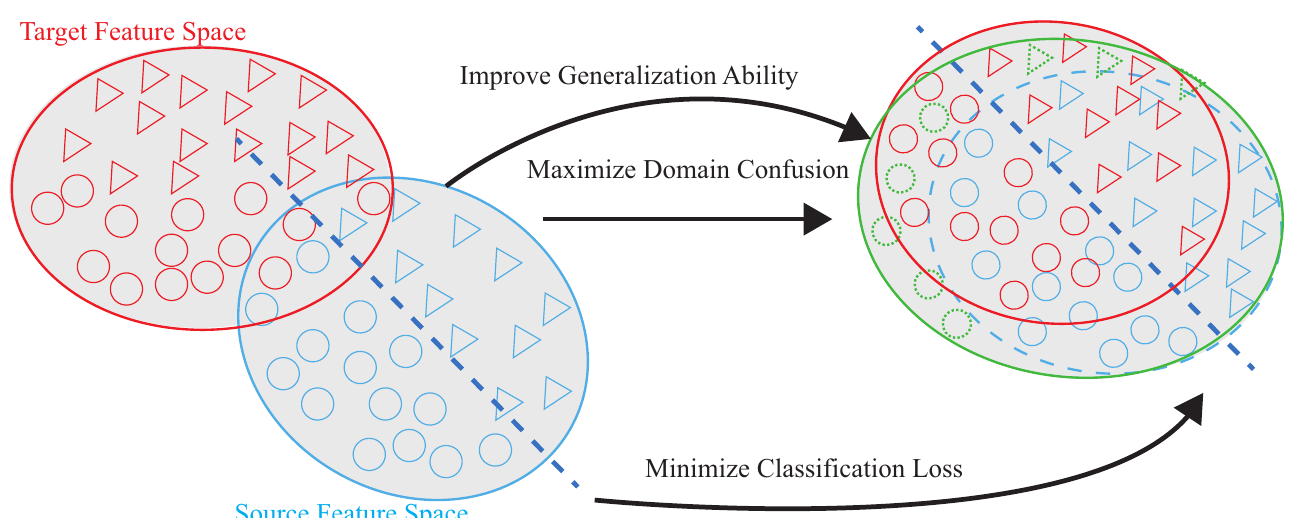
Figure 2. DADA-AD scheme improves generalization ability, maximize domain confusion, and minimize classification loss for source and target